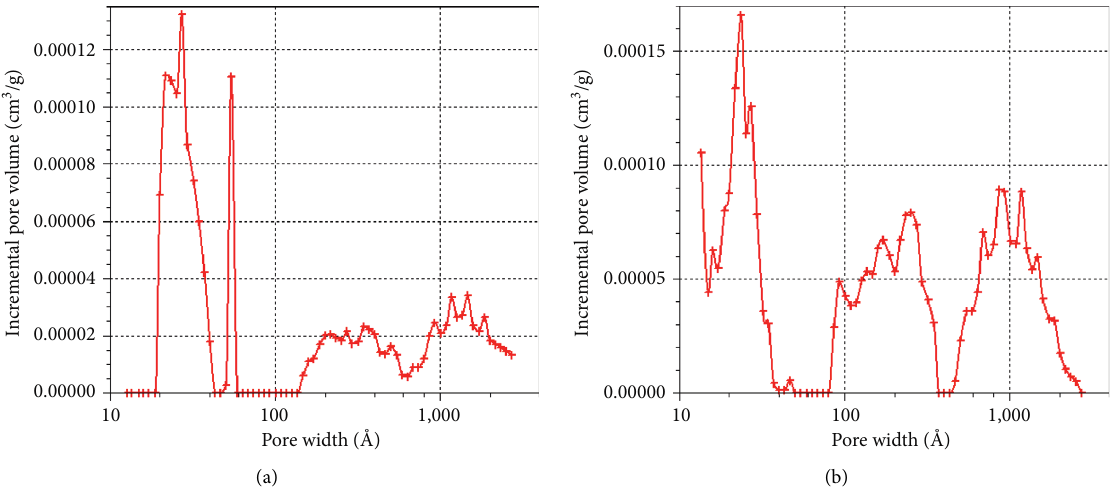
Figure 5: Relationship between the coal pore volume increments and the pore diameters of the No. 6 coal seam (˚A is 10 − 1 nm): (a) hard coal; (b) soft